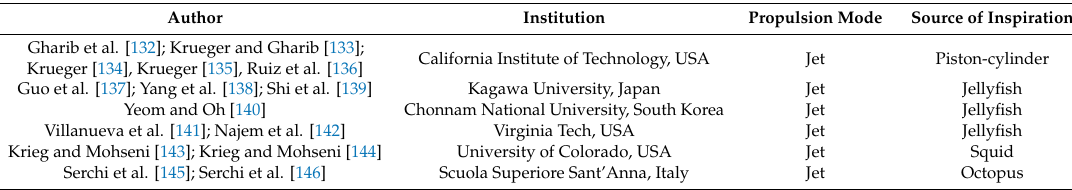
Table 3. Summary of non-swimming